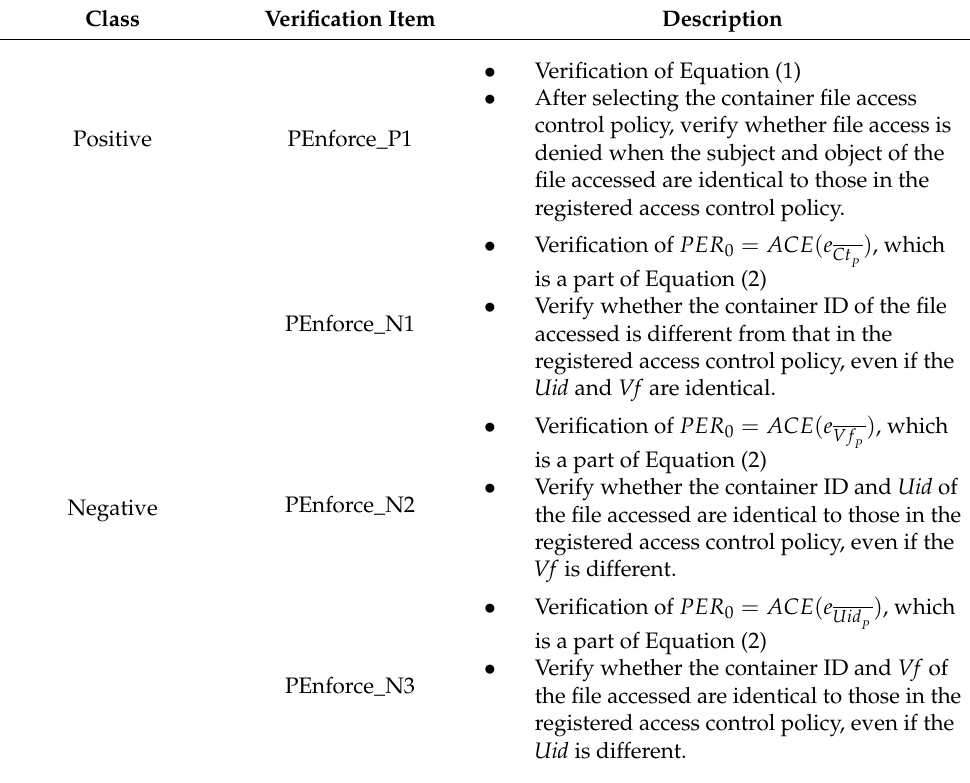
Table 1. Functionalities used for